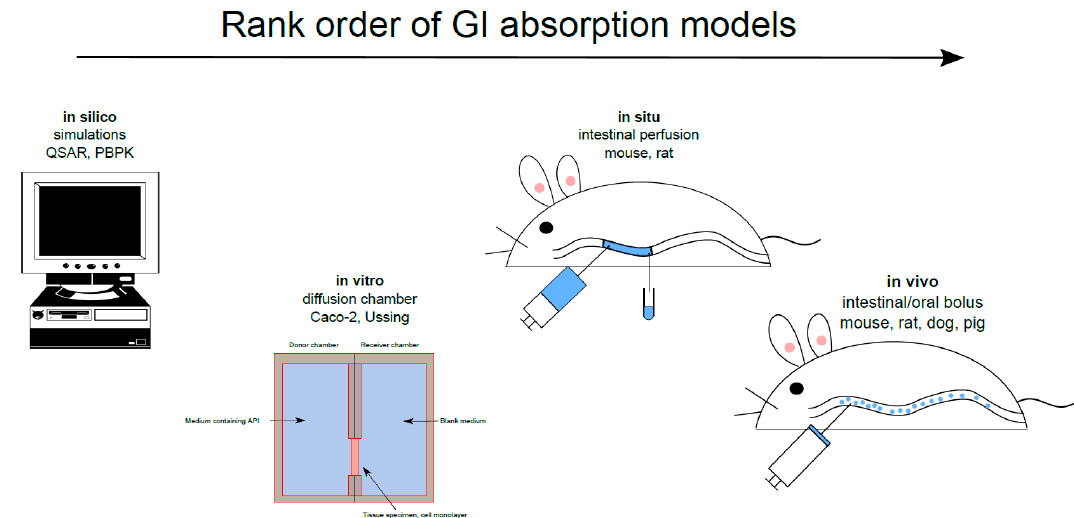
Figure 1. Gastrointestinal (GI) non-clinical absorption models ranked according to the order of their use in the drug discovery/development process for investigating transport mechanisms, determining intestinal permeability, and predicting plasma pharmacokinetic profiles. API = active pharmaceutical ingredient; PBPK = physiologically based pharmacokinetics; QSAR = quantitative structure-activity relationships.